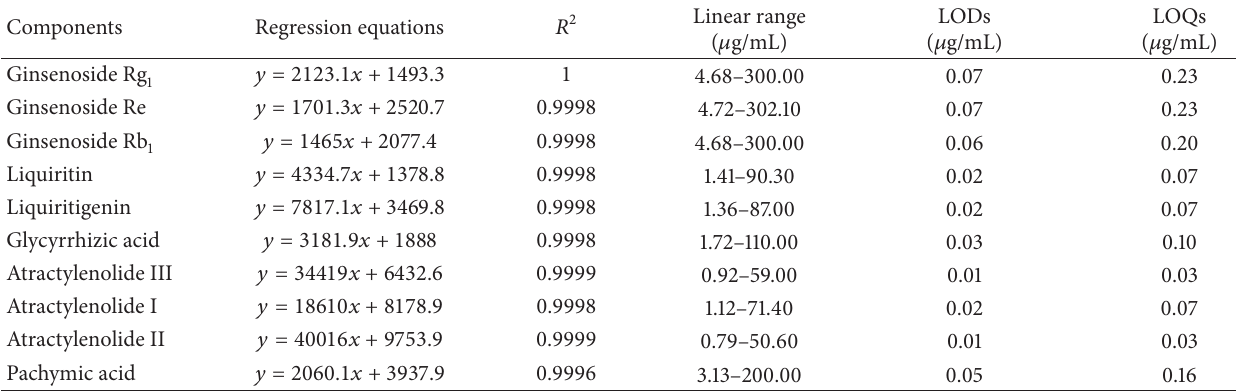
Table 1: The linear regression data, LODs, and LOQs of ten compounds.